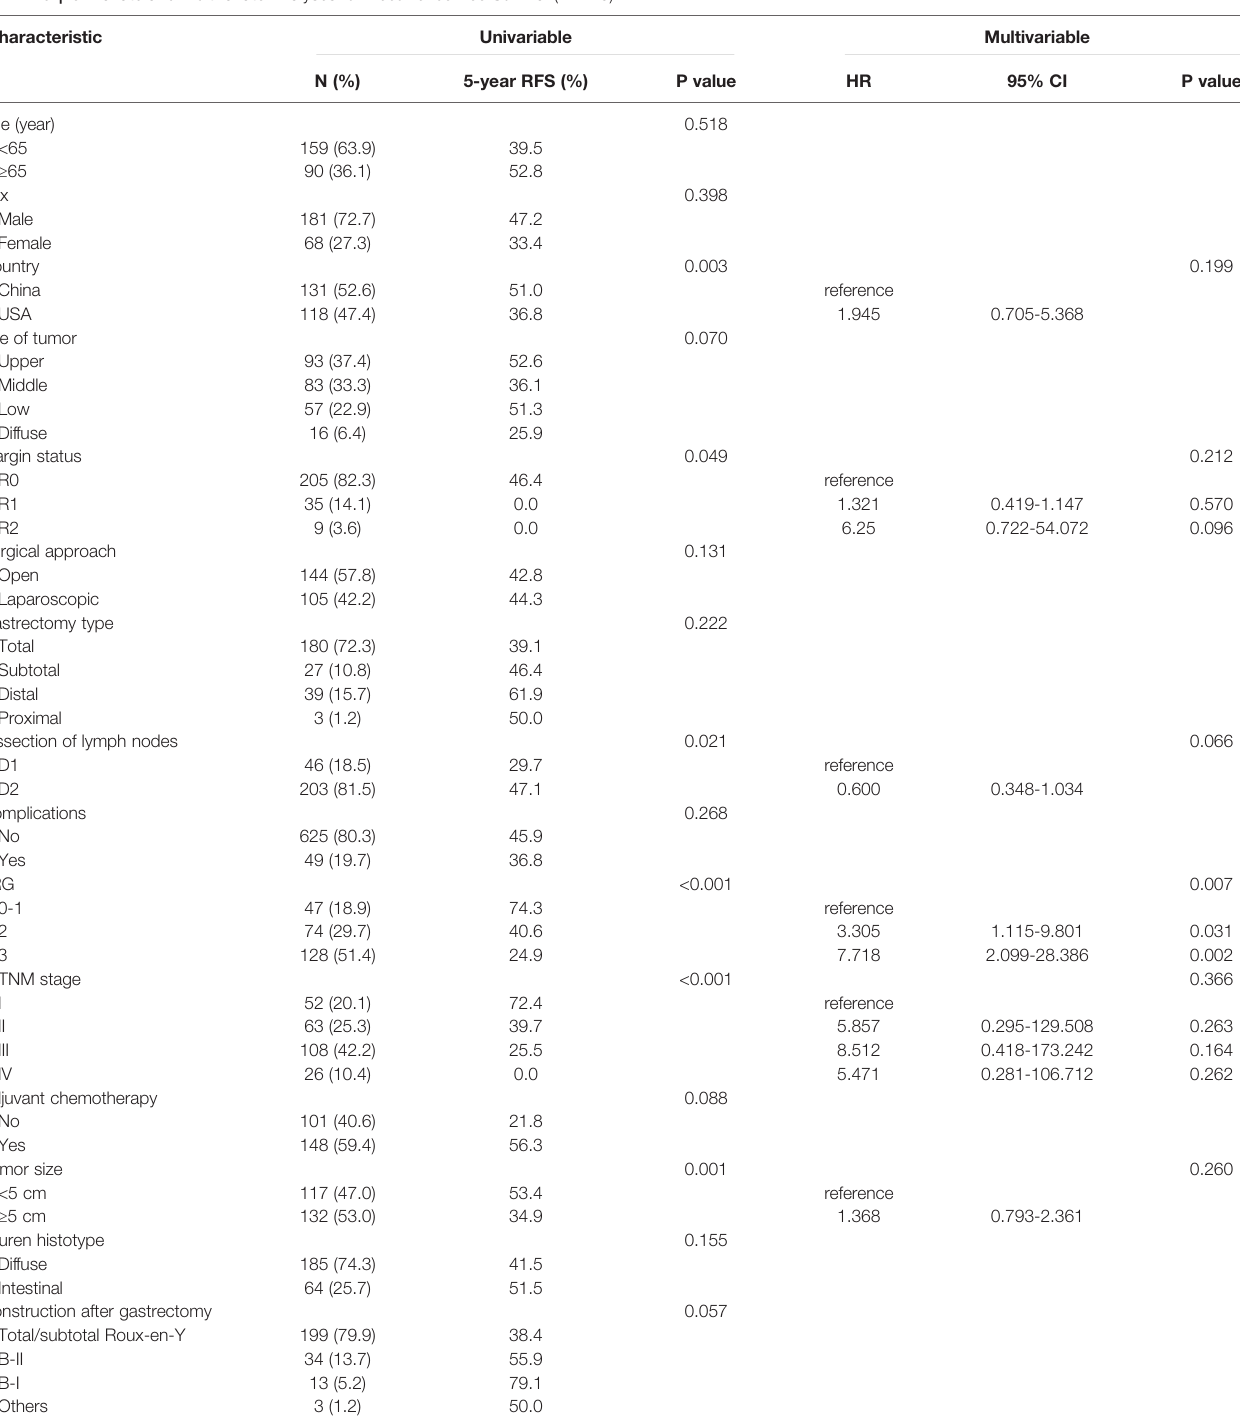
TABLE 3 | Univariate and Multivariate Analyses for Recurrence-free Survival (N=249).